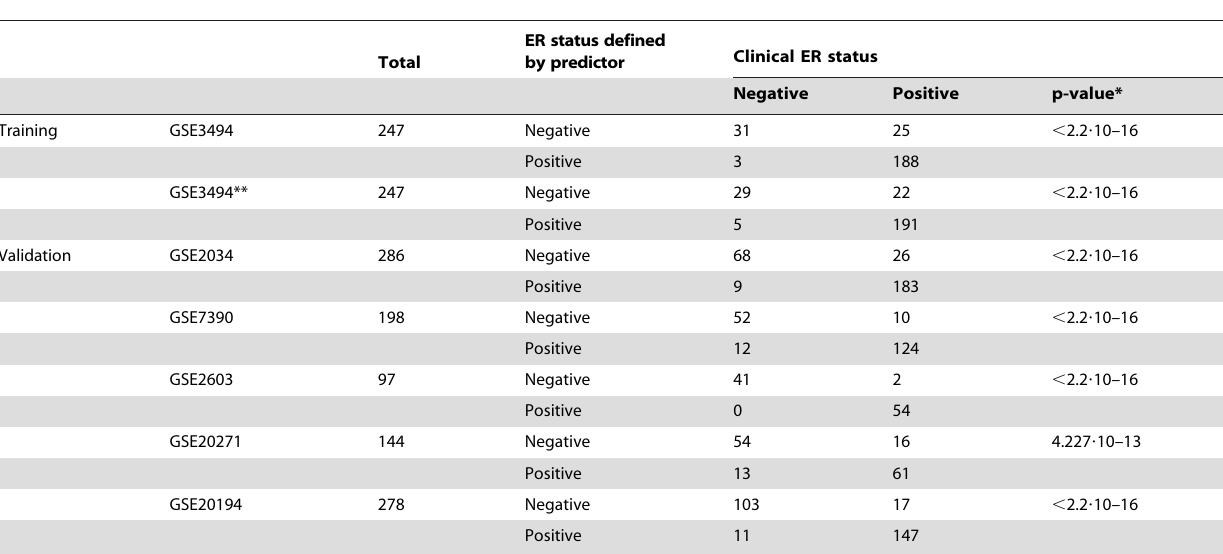
Table 2. Correlation of microarray–based expression profiling data with routinely established ER status.